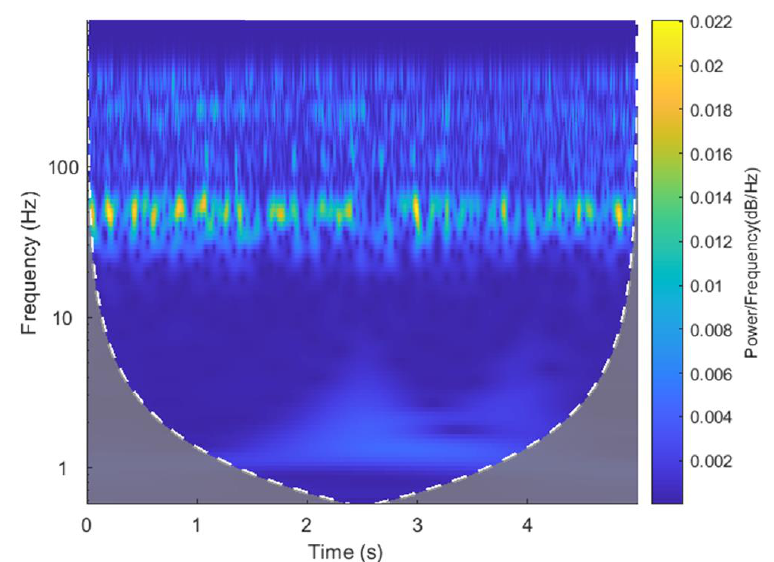
Figure 21. Wavelet-transformed time-frequency image of the measured value from Channel 7 using frequency-domain data.